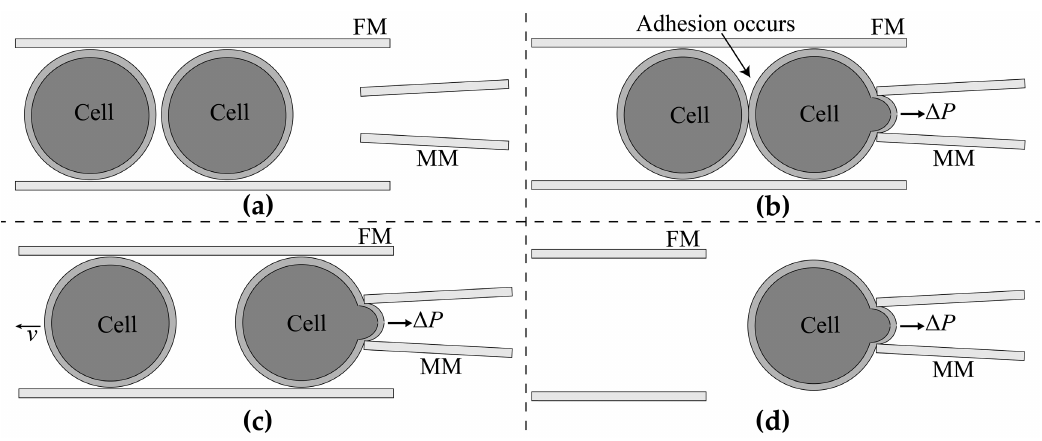
Figure 1. The operation process of new micropipette aspiration (MA) process for batch cells. ( a ) Insert measuring micropipette (MM) into the feeder micropipette (FM). ( b ) Deliver the cells to the microscopic field and hold the target cell by the MM. ( c ) Draw back the adhesive cells with the calculated negative pressure. ( d ) Withdraw the FM and measure the Young’s modulus of the cell by MM.